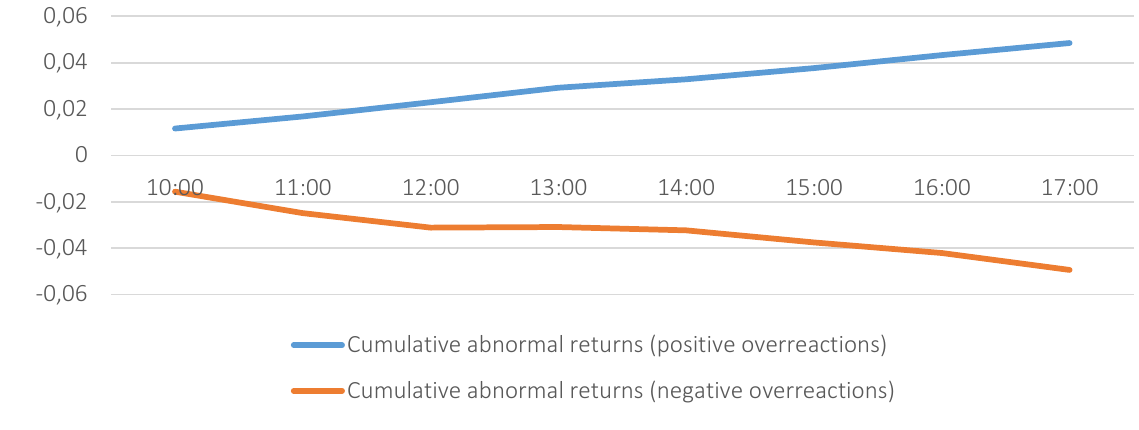
Figure 3. Dynamics of cumulative abnormal returns: case of